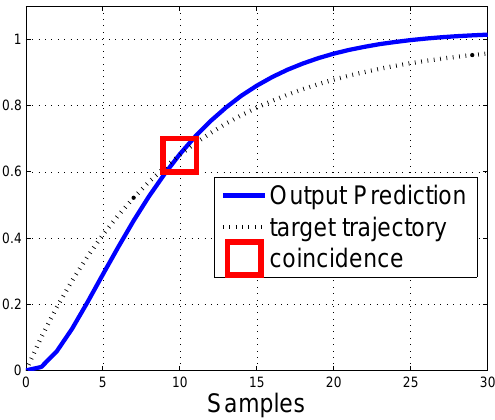
Figure 2. Conceptual illustration of PFC control law definition matching prediction to target trajectory at a single